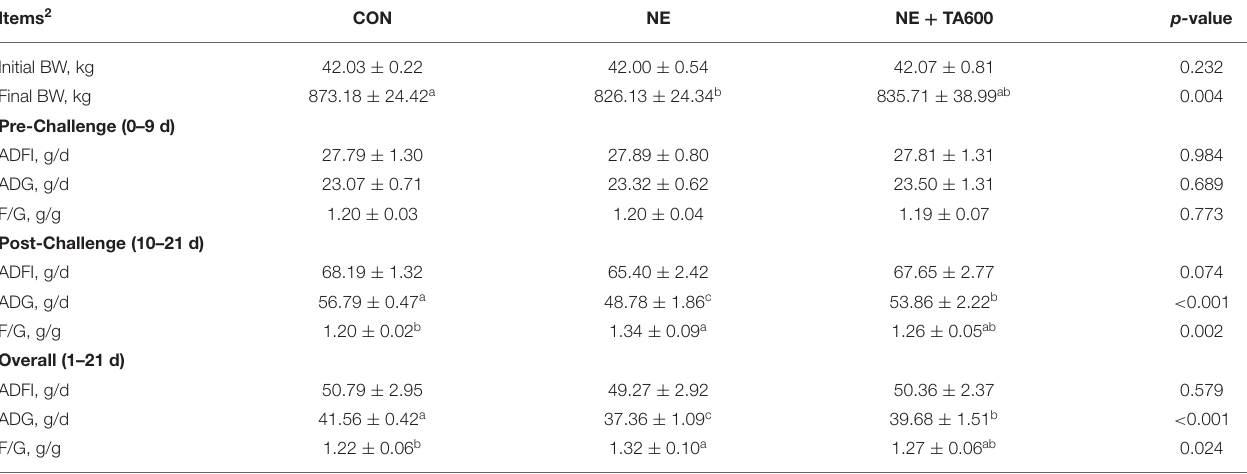
TABLE 1 | Effect of dietary TA supplementation on the growth performance of broilers challenged with subclinical necrotic enteritis 1